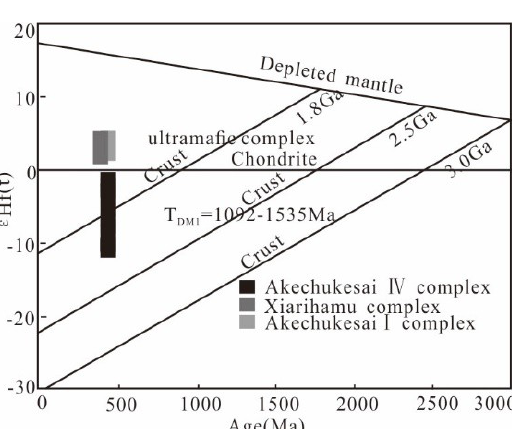
Table 3. Zircon Lu-Hf isotopic compositions of gabbro in the Akechukesai Ⅳ mafic -ultramafic complex. No. Age (Ma)